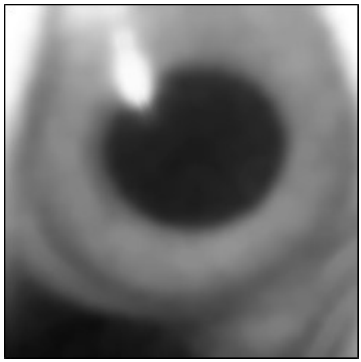
Figure 36. Original image.